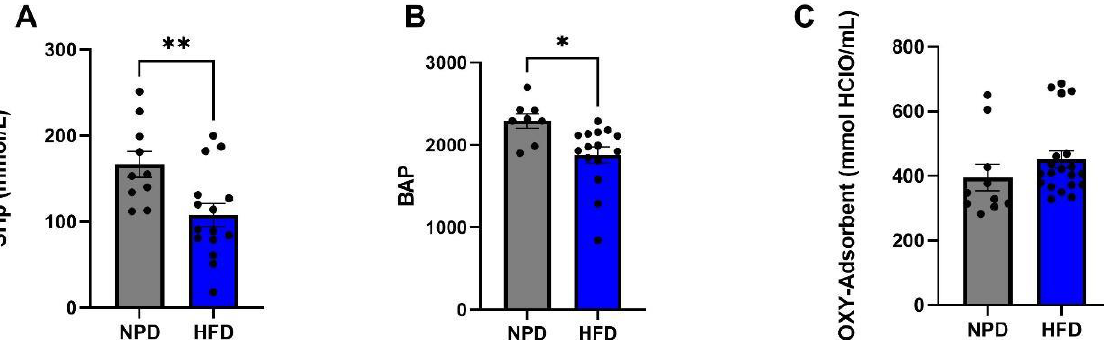
Figure 5. Antioxidant status in NPD and HDF experimental groups after 8 weeks (T1) of HFD. ( A ) SHp Test. Thiols groups levels (mmol/L) difference between NPD and HFD groups after 8 weeks of HFD. ( B ) BAP Test. Biological antioxidant potential levels (mmol/L) difference between NPD and HFD groups after 8 weeks of HFD. ( C ) OXY-Adsorbent Test. The antioxidant power of the plasma barrier levels (mmol HClO/mL) difference between NPD and HFD groups after 8 weeks of HFD. Statistical significance indicated for (*) p < 0.05 and (**) p < 0.01.